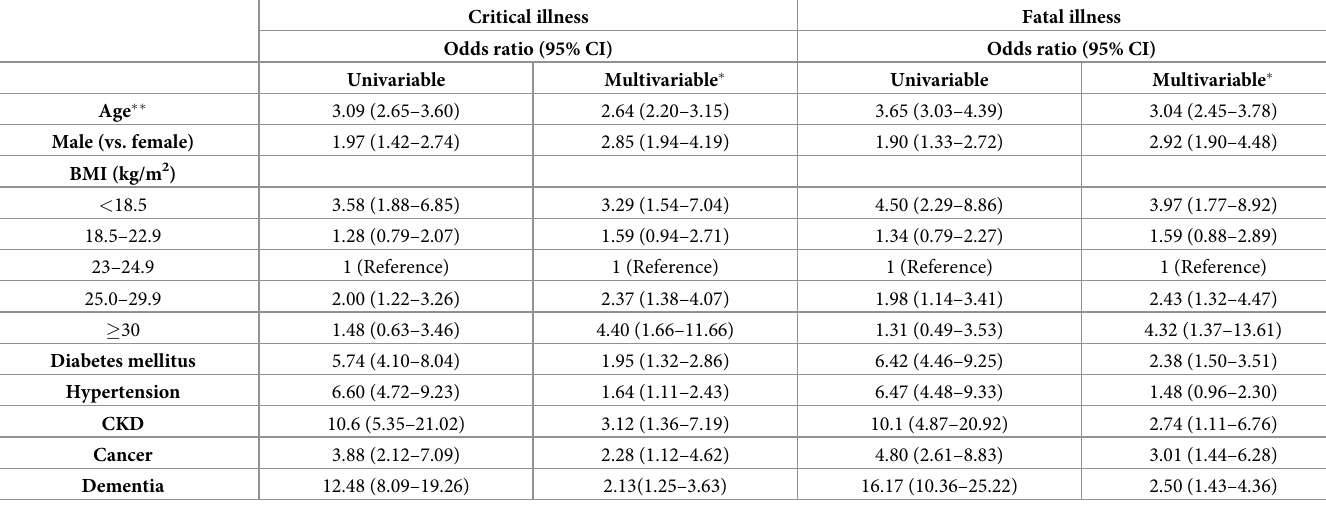
Table 2. Logistic analyses of in critical and fatal illness